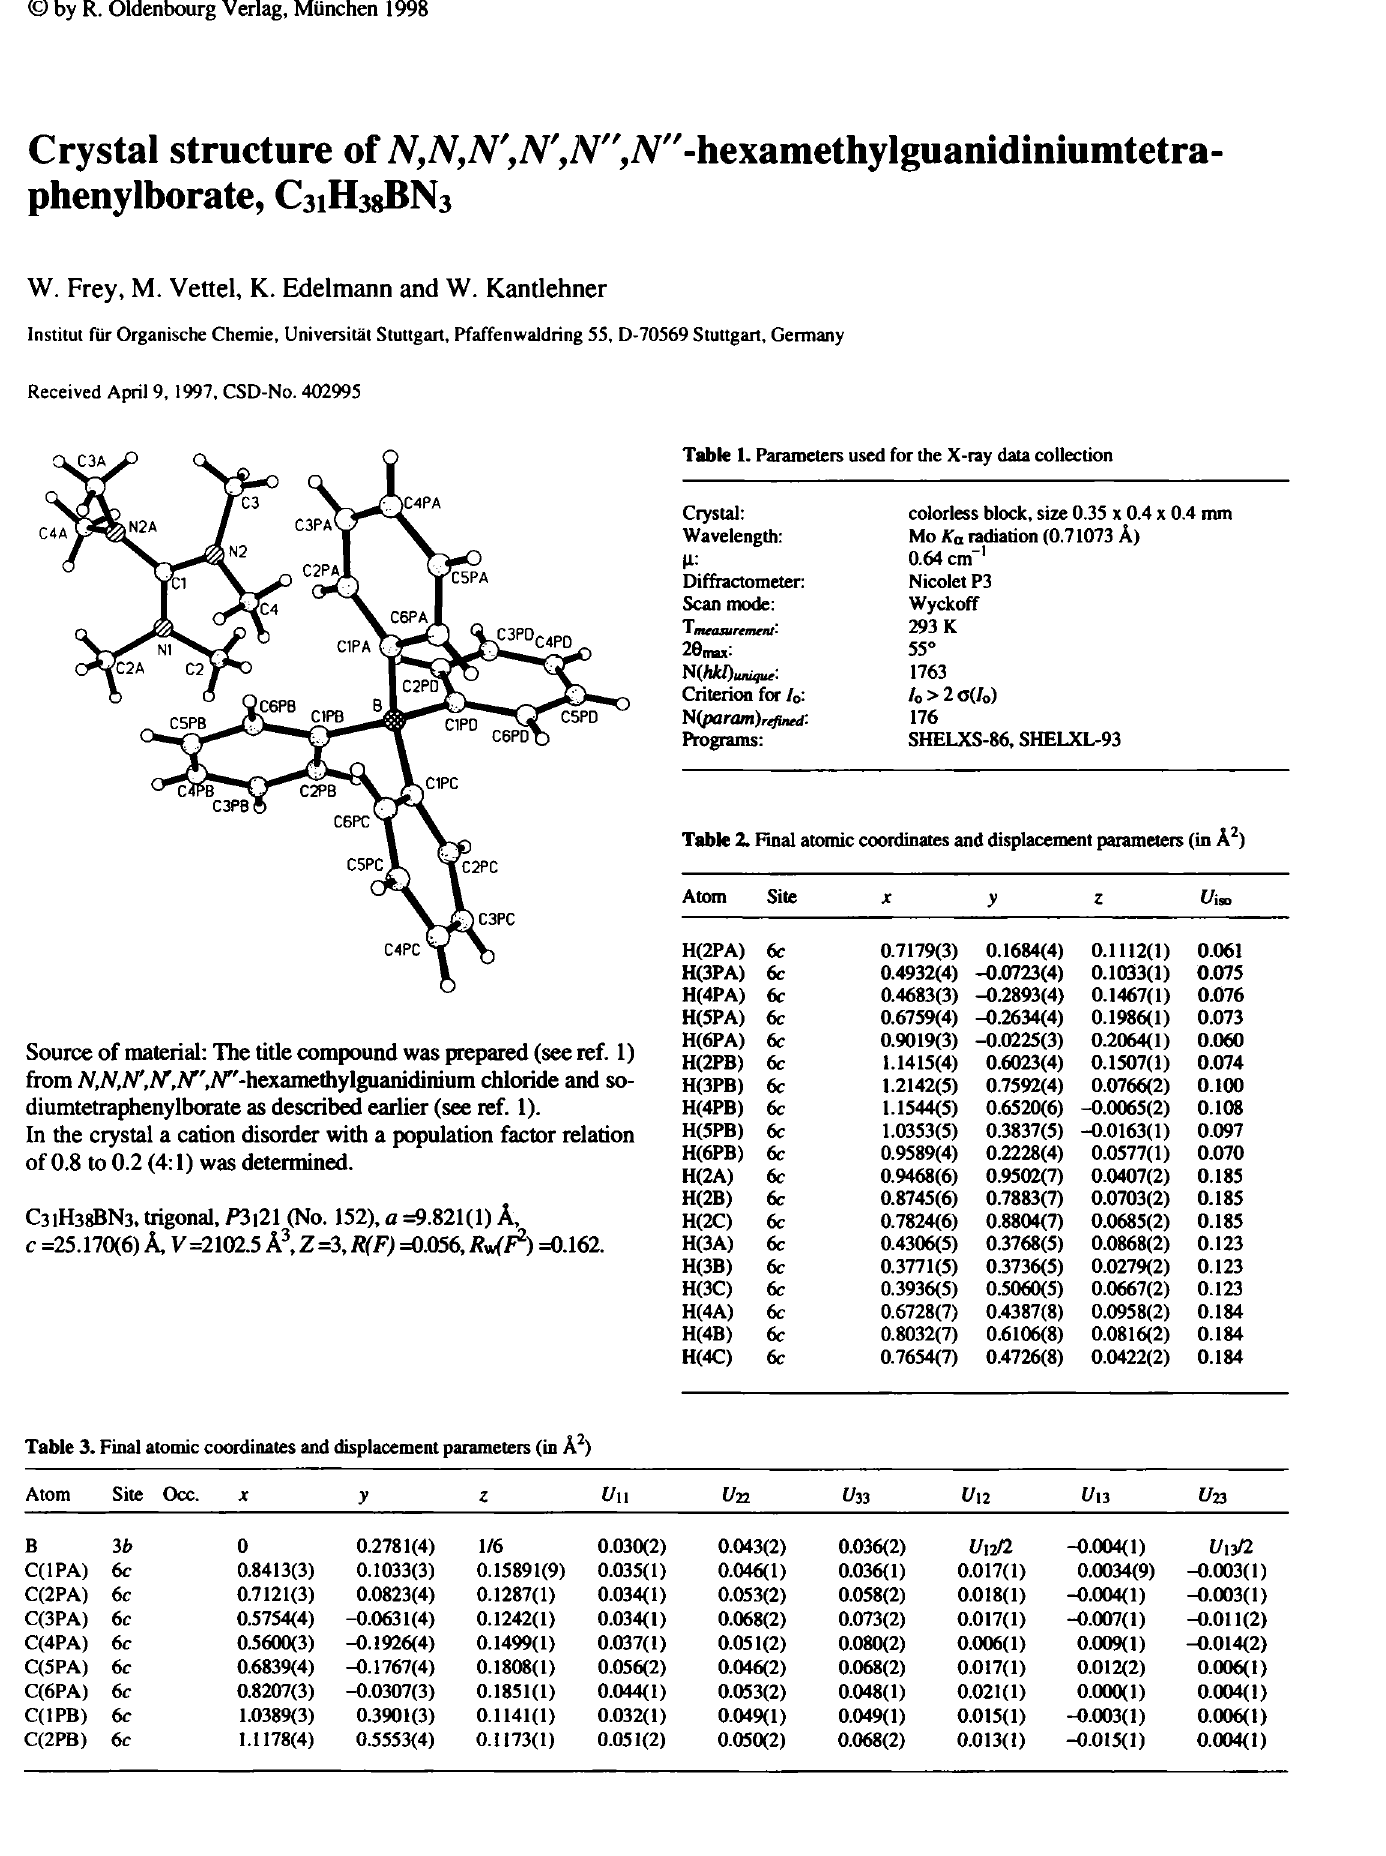
Table 1. Parameters used for the X-ray data collection Crystal: